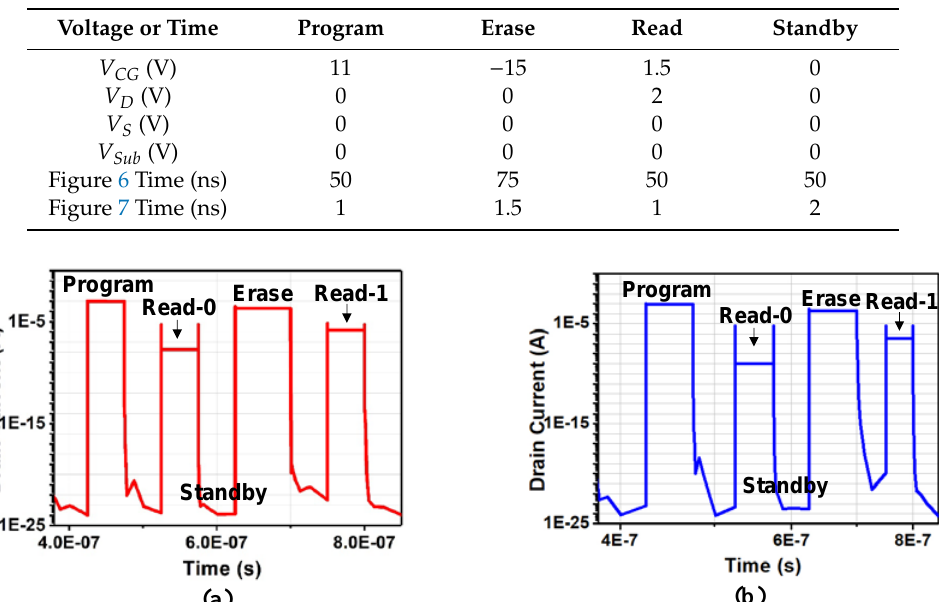
Figure 6. The I d change curve of ( a ) UFGM with p + FG and ( b ) UFGM with n + FG with time in a change curve of ( a ) UFGM with Figure 6. The transient simulation using the operation voltage scheme in Table 2. transient simulation using the operation voltage scheme in Table 2. 𝐼𝐼 𝑑𝑑